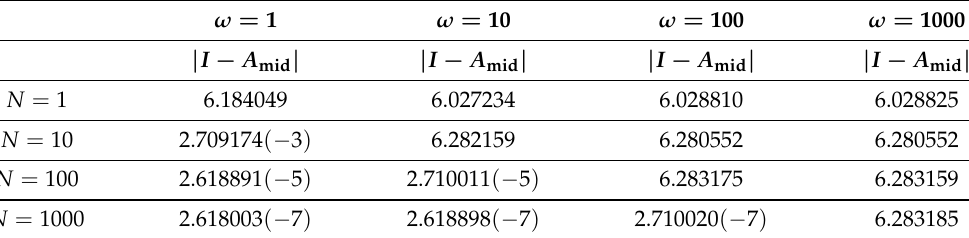
Table 1. The absolute values for the real part of the error (55) of the Midpoint rule for N = 1, 10, 100, 1000 and ω = 1, 10, 100, 1000.